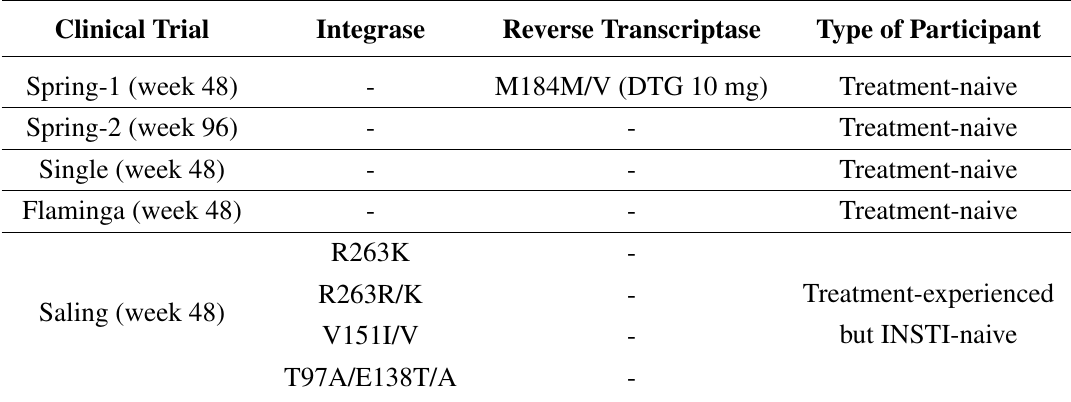
Table 3. Examples of new IN and RT drug resistant mutations emerging after treatment failure with